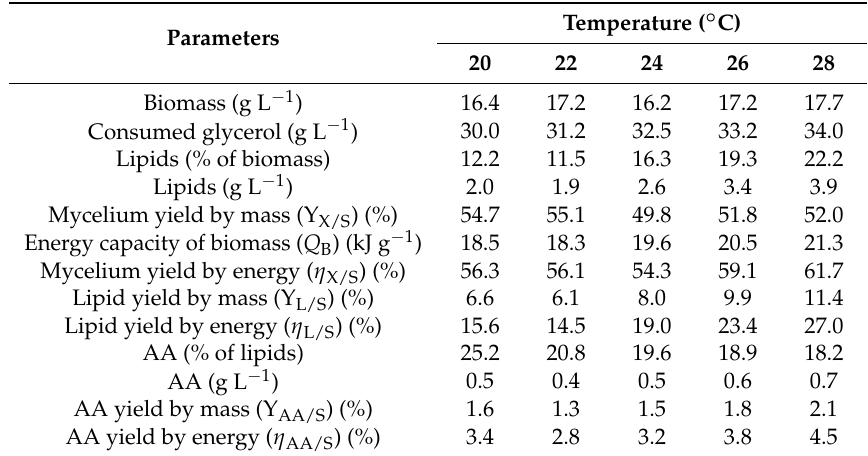
Table 5. The effect of pH on the yields of biomass, lipids, and arachidonic acid in M. alpina NRRL-A- 10995 in the stationary